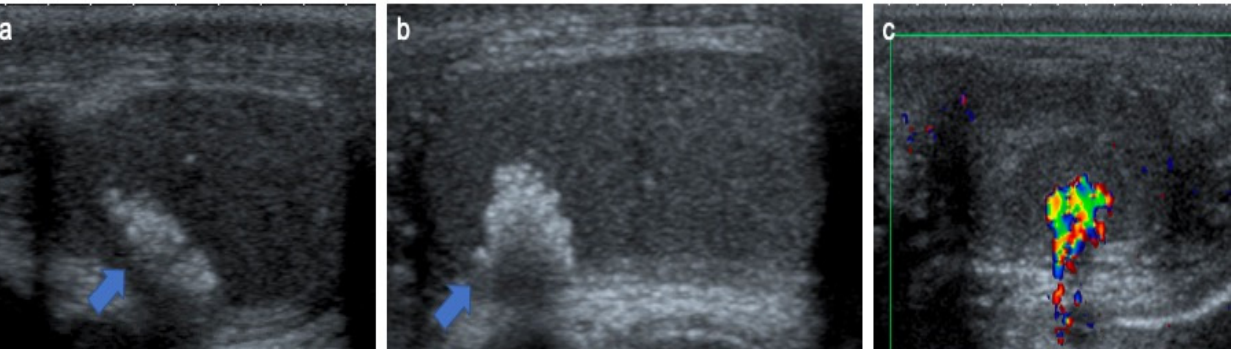
Figure 6. Sertoli-cell tumor in an 8-years-old boy with Peutz–Jeghers syndrome. Transverse ( a ), longitudinal ( b ) gray-scale B-mode and transverse color Doppler ( c ) US of the testis. Images show a hypoechoic nodule mostly calcified with irregular calcifications (blue arrow) causing posterior shadowing and artifacts on color Doppler imaging. US, ultrasonography. The child presented with acceleration of his growth and gynecomastia. Later, he developed nasal polyps and mucocutaneous pigmentation and Peutz–Jeghers syndrome was confirmed. The patient underwent conservative surgery.